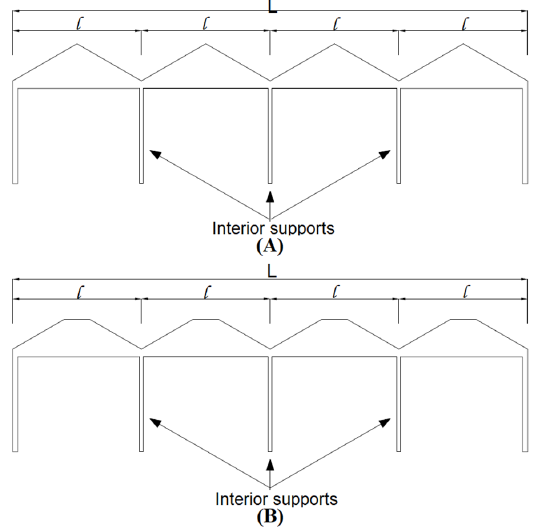
Figure 2. Folded plate roof number of internal supports design variable (V1): ( A ) “V” type folded plate roofed building elevation view; ( B ) Three-segment type folded plate roofed building elevation view.